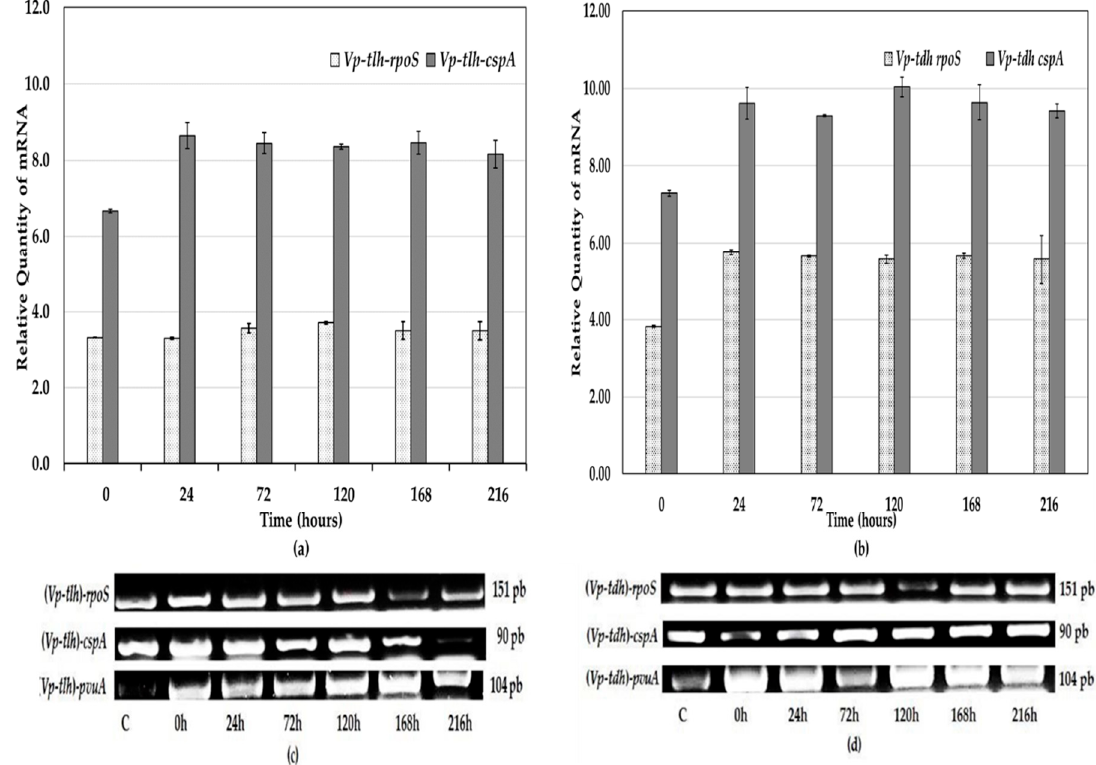
Figure 3. Gene expression analysis of the rpos and CspA genes of the V. parahaemolyticus pathogenic ( Vp-tdh ) and nonpathogenic ( Vp-tlh ) strains isolated from live tropical oysters during refrigerated storage at 7 ± 1 ◦ C for 216 h in tryptone soy broth. The error bars are the standard deviations from three independent experiments. The relative expression levels were calculated with respect to the expression of pvuA , which was used as an endogenous reference gene. Reverse transcription PCR (RT-PCR) of the expressed rpos and CspA genes of the V. parahaemolyticus nonpathogenic ( Vp-tlh ) ( a ) and pathogenic ( Vp-tdh ) ( b ) strains was performed. A comparison of the gene expression of rpos and cspA by an agarose gel electrophoresis analysis of the RT-PCR amplification products of the V. parahaemolyticus nonpathogenic ( Vp-tlh ) ( c ) and pathogenic ( Vp-tdh ) ( d ) strains is shown. The cells were exposed to cold shock by decreasing the temperature from 35 ◦ C for 2 h (lane 0 h) to 7 ◦ C for 216 h. The expression levels of rpos and cspA at 40 cycles of cDNA amplification are shown. The gene expressions levels of rpos and (151 bp) and cspA (90 bp) showed variations in the band intensity during refrigerated storage for 216 h. The housekeeping gene ( pvuA ) of the 104 bp product was used as an internal control. V. parahaemolyticus DNA was used as a positive control (C) for PCR. All experiments were repeated three times.